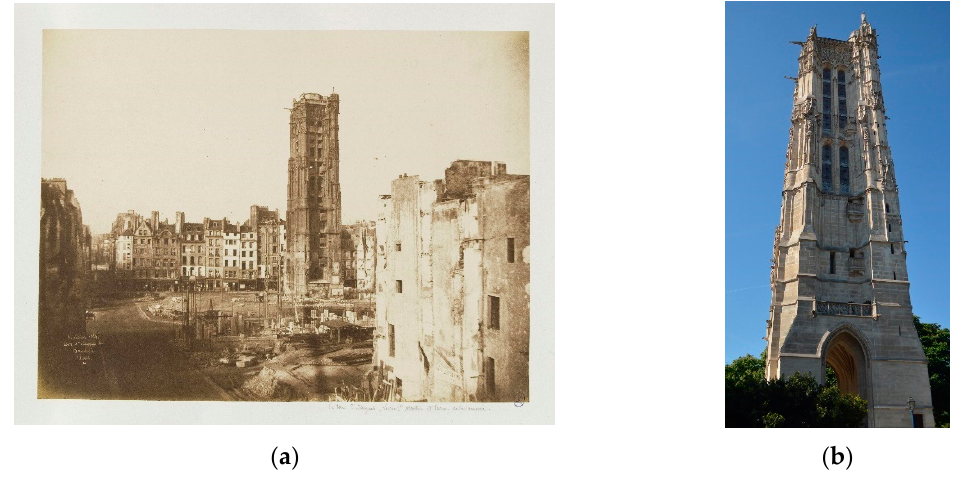
Figure 3. The tour Saint Jacques in Paris. ( a ) The tower in a historical photograph by Melville; and ( b ) in the contemporary state.